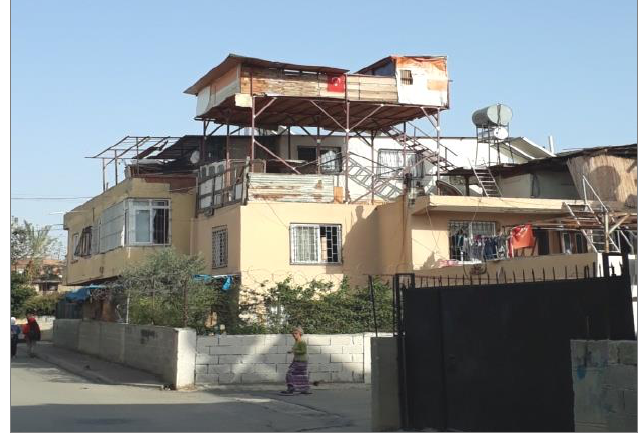
Figure 3 Housing constructions in the informal neighborhoods of Toroslar District